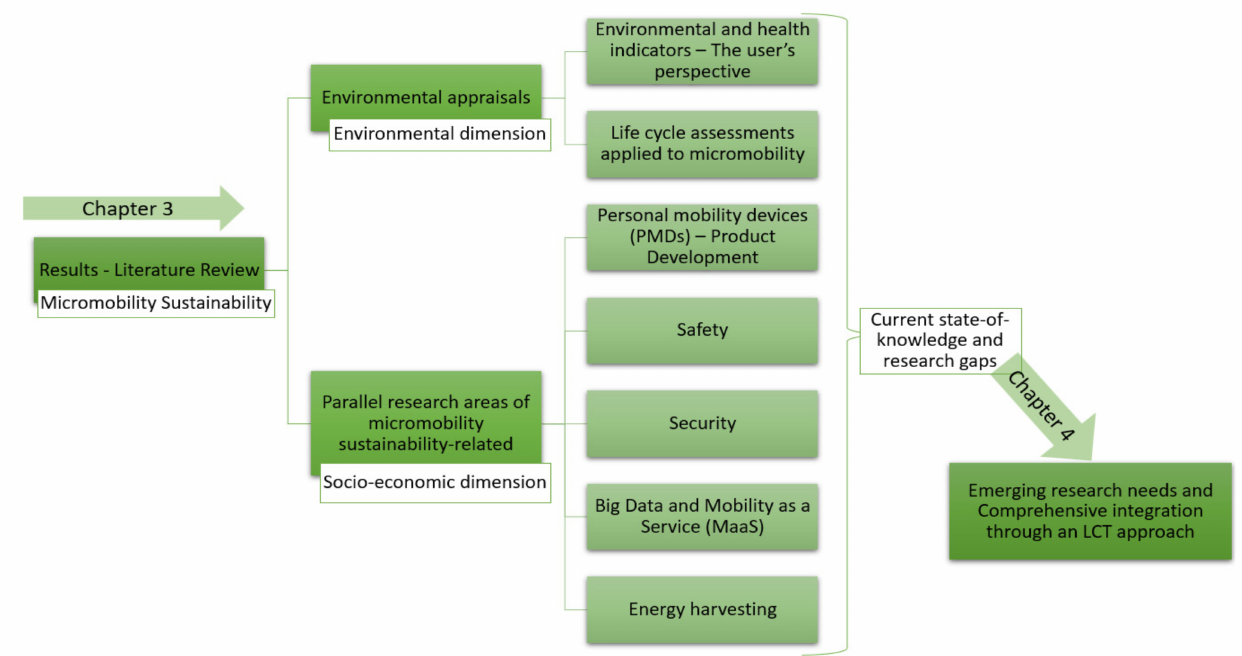
Figure 3. Structural organization of